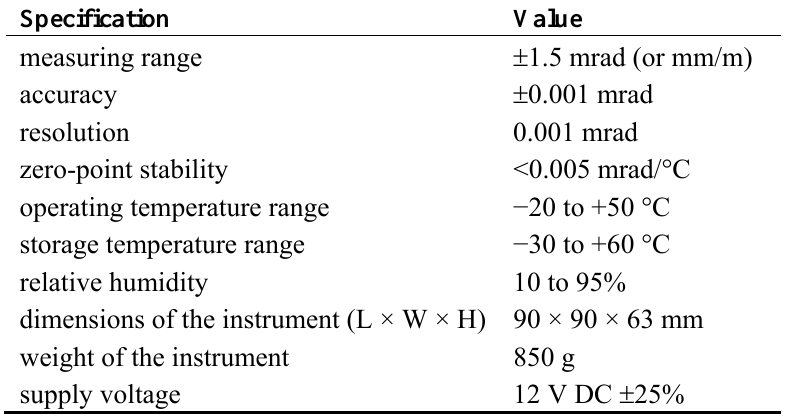
Table 1. Specifications of the inclinometer [27].